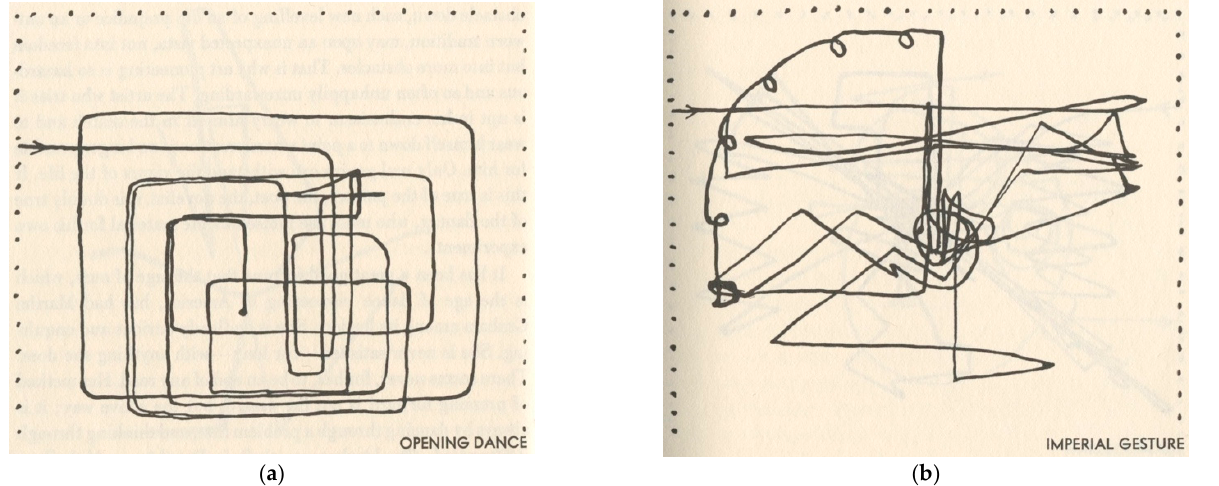
Figure 4. Arch Lauterer, floor plan for ( a ) Opening Dance (1937) and ( b ) Imperial Gesture (1937) of Martha Graham, black and white print, 2”× 2”, in (Armitage [1937] 1985, pp. 42–43).